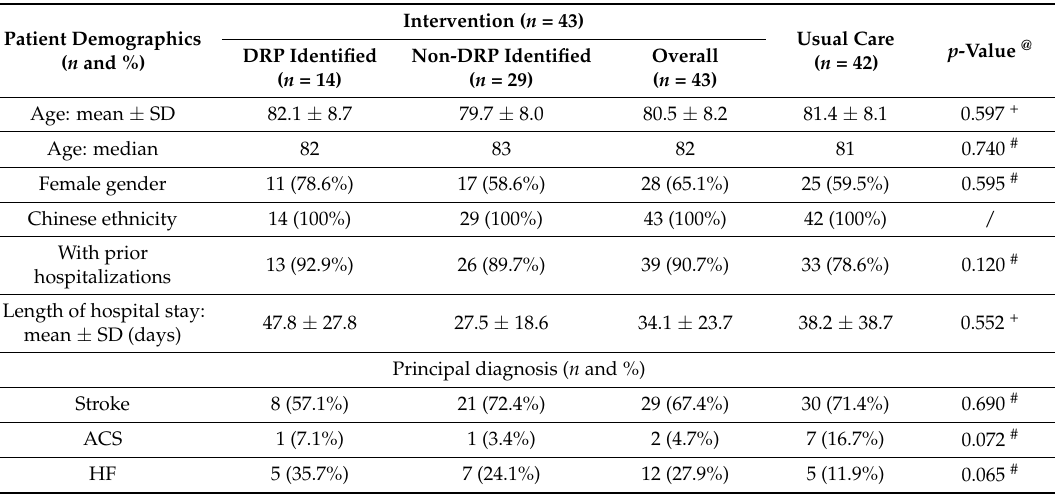
Table 1. Demographic statistics of study